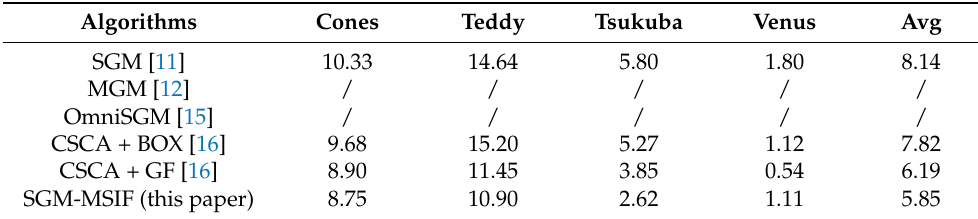
Table 3. Comparison of EMRs in All regions of six algorithms (%). “/”: the results are not available in the references.